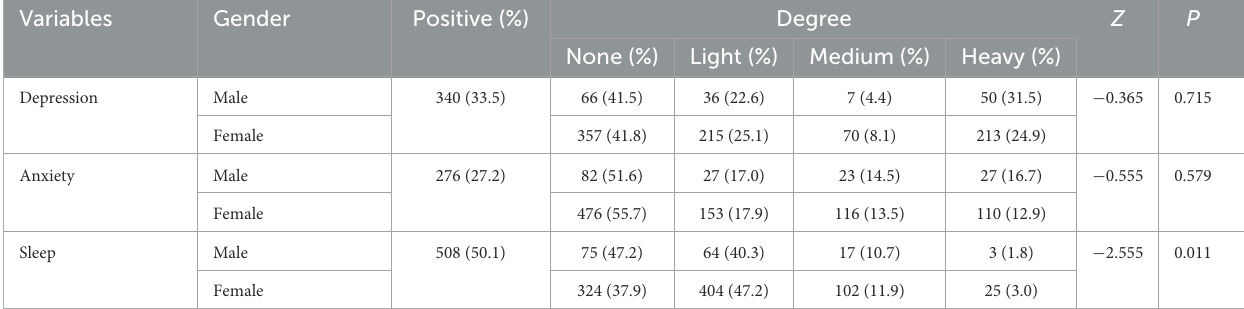
TABLE 2 Positive rate of depression, anxiety and sleep disorders among 1,014 nucleic acid collectors under closed-loop management [ N = 1,014(%)]. Variables